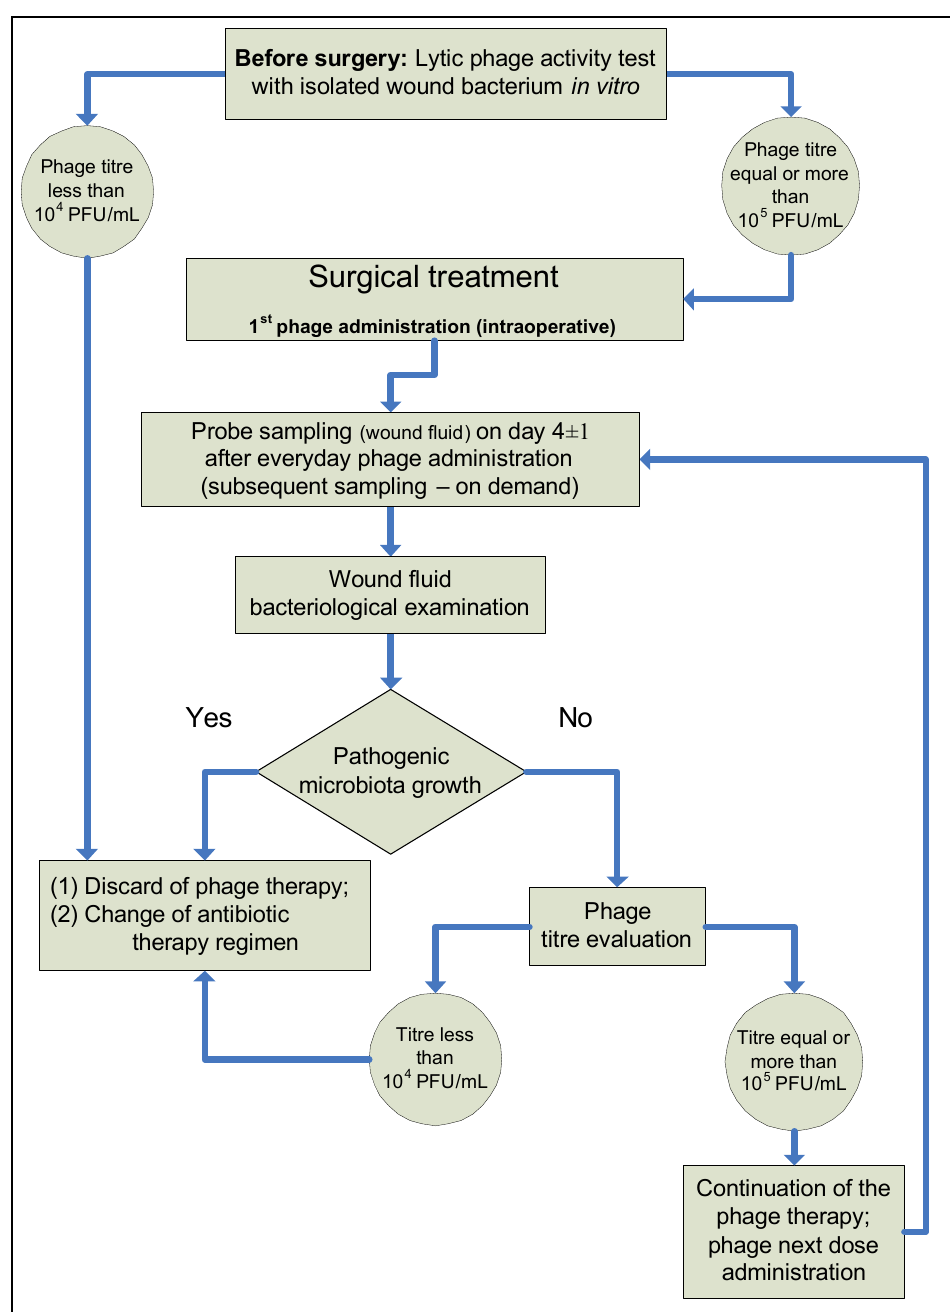
Figure 2. Diagnostic and treatment protocol of combined phage and antibiotic PJI treatment. Because phage therapy was used in the SG in combination with antibiotics (not as monotherapy), all patients of this group were additionally prescribed etiotropic antibiotic therapy after surgical treatment, for up to twelve weeks, according to the regimens de- scribed below. Under hospital conditions (first two weeks), depending on the pathogen, vancomycin was administered as an intravenous drip infusion, at a dose of 1.0 g twice a day, or cefazolin as an intravenous drip infusion at a dose of 2.0 g three times a day, [44]. After discharge, during outpatient treatment, patients were prescribed with oral antibiot- ics, based on the organism and allergy profile, antibiogram and renal function, according to the following regimens: 1. Ciprofloxacin at a dose of 0.5 g, twice a day for twenty-one days; and rifampicin at a dose of 450 mg, twice a day for ten weeks;